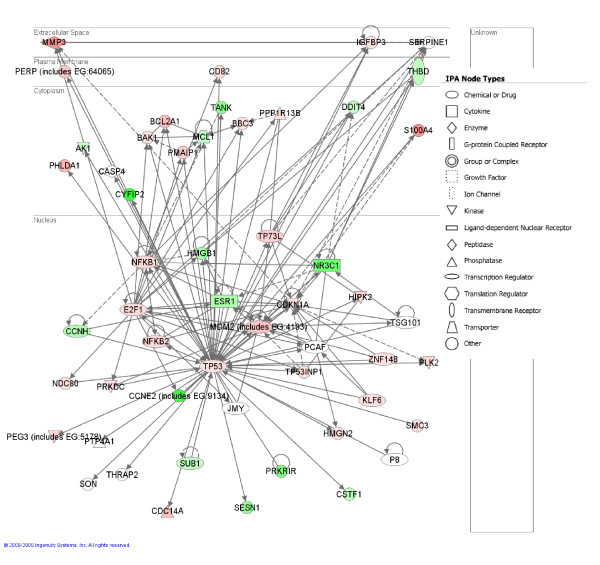
p53-regulated pathway analysis using the Ingenuity Pathway Knowledge Base (IPKB). This figure illustrates potential functional relationships of TP53 responsive genes de-regulated in the muscles of Dox-treated Tg(HQK) mice. Direct (solid lines) and indirect (dashed lines) interactions reported for these genes (grey shading) in the IPKB database. Color shading corresponds to the type of de-regulation: red for up-regulated genes, and green for down-regulated genes. The shape of the node indicates the major function of the protein (see key), and a line denotes binding of the products of the two genes while a line with an arrow denotes 'acts on'.